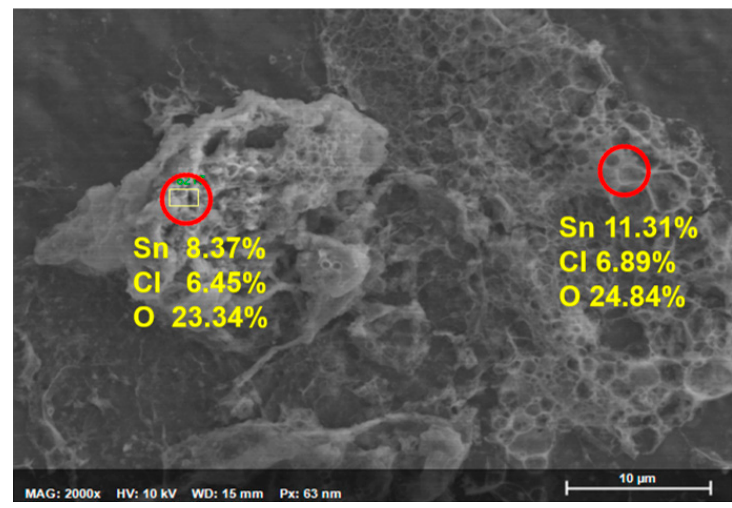
Figure 6. SEM image of SnCl 4 hydrolyzates and the element composition of the circled area measured by EDX.